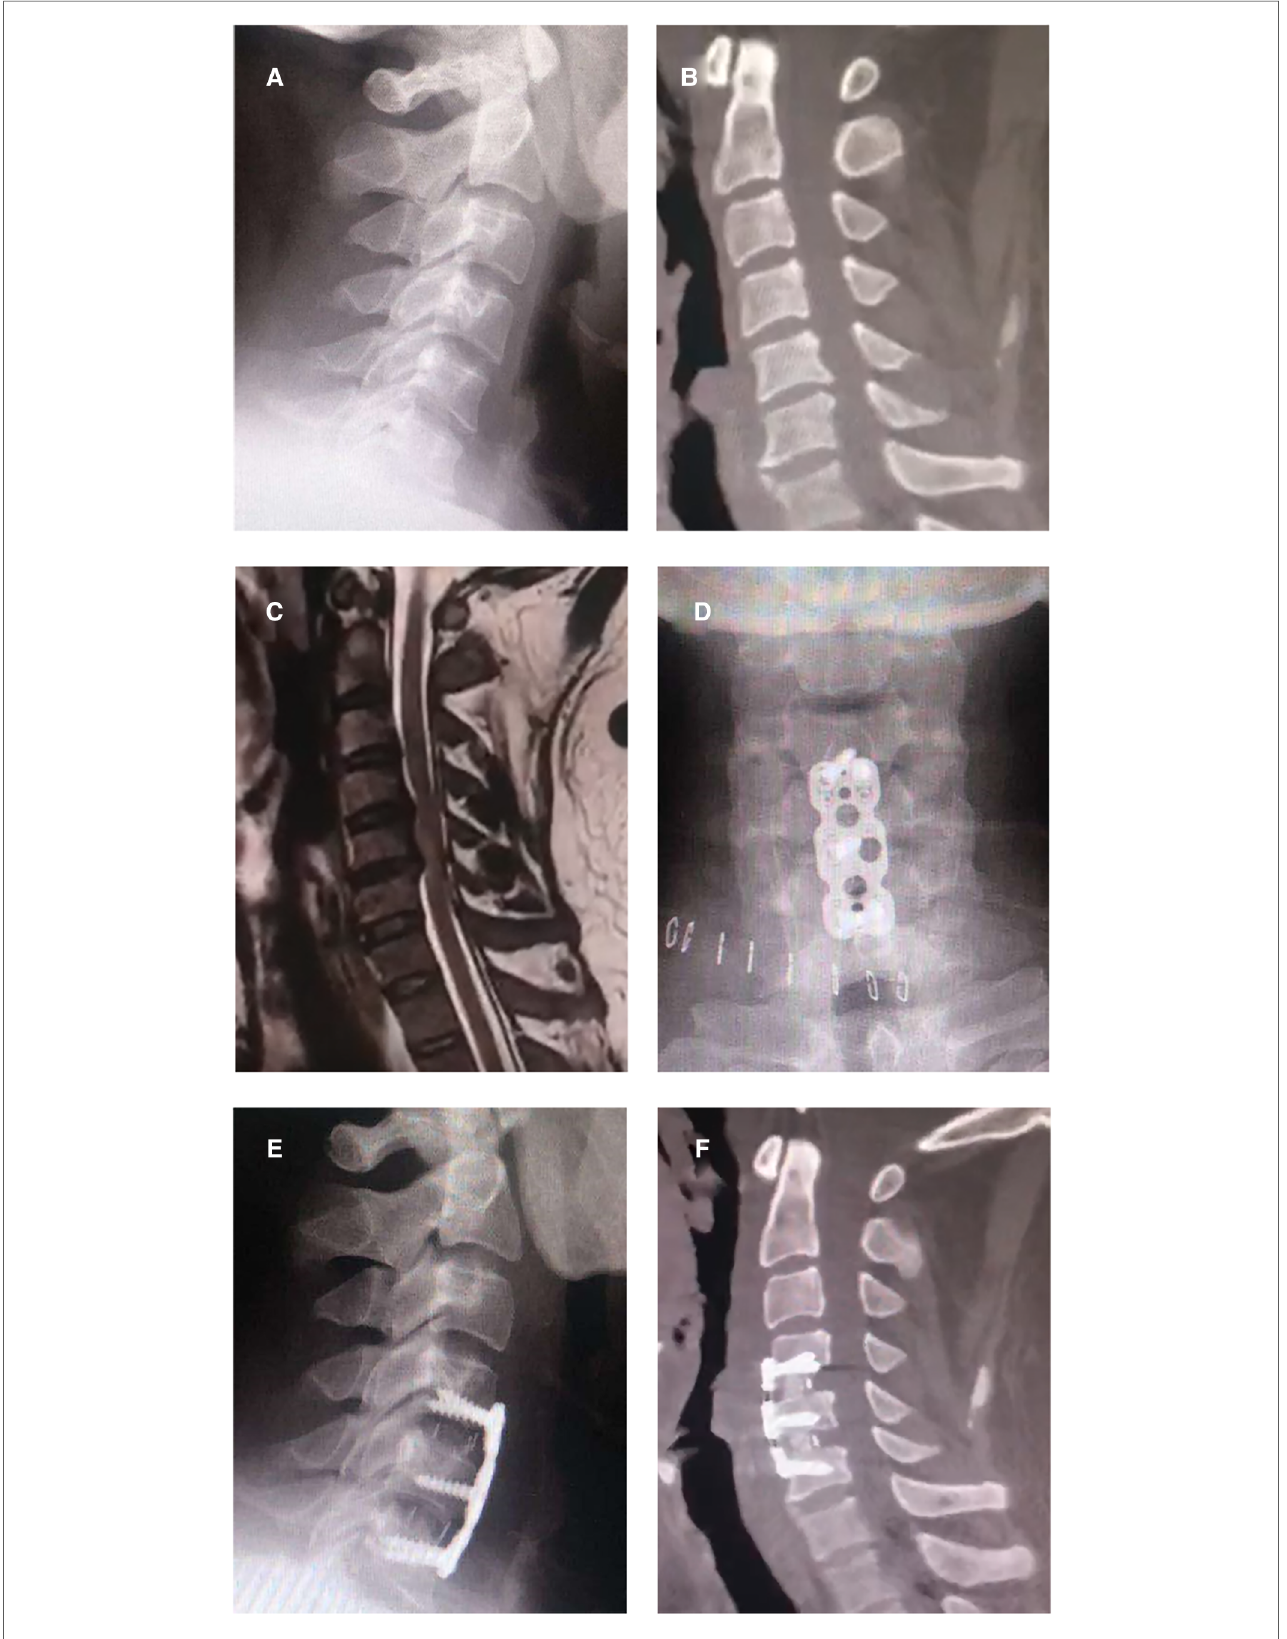
FIGURE 1 Preoperative and postoperative images of anterior cervical discectomy and fusion. ( A ) A preoperative lateral x-ray image of the patient; ( B ) A preoperative sagittal CT image of the patient; ( C ) A preoperative sagittal MR image, revealing spinal stenosis at the C4/5 and C5/6 levels secondary to central disc herniation; ( D – F ) Postoperative x-ray and CT images, revealing accurate placement of the plates, screws, and